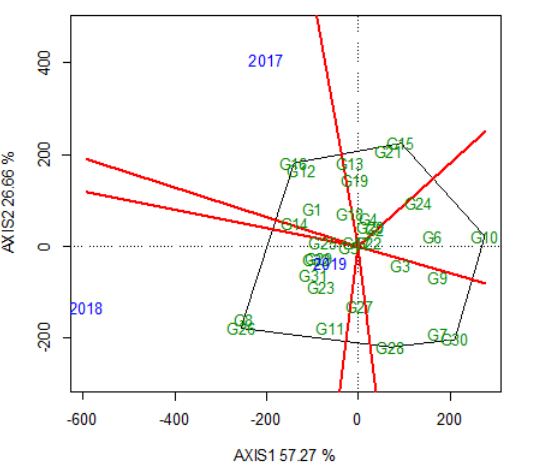
Figure 3 A which-won-where biplot. In the sector within which environments 2018 and 2019 are plotted, the genotypes G8 and G26 have the highest yields, whereas in the sector in which environment 2017 is plotted, G12 and G16 have the highest